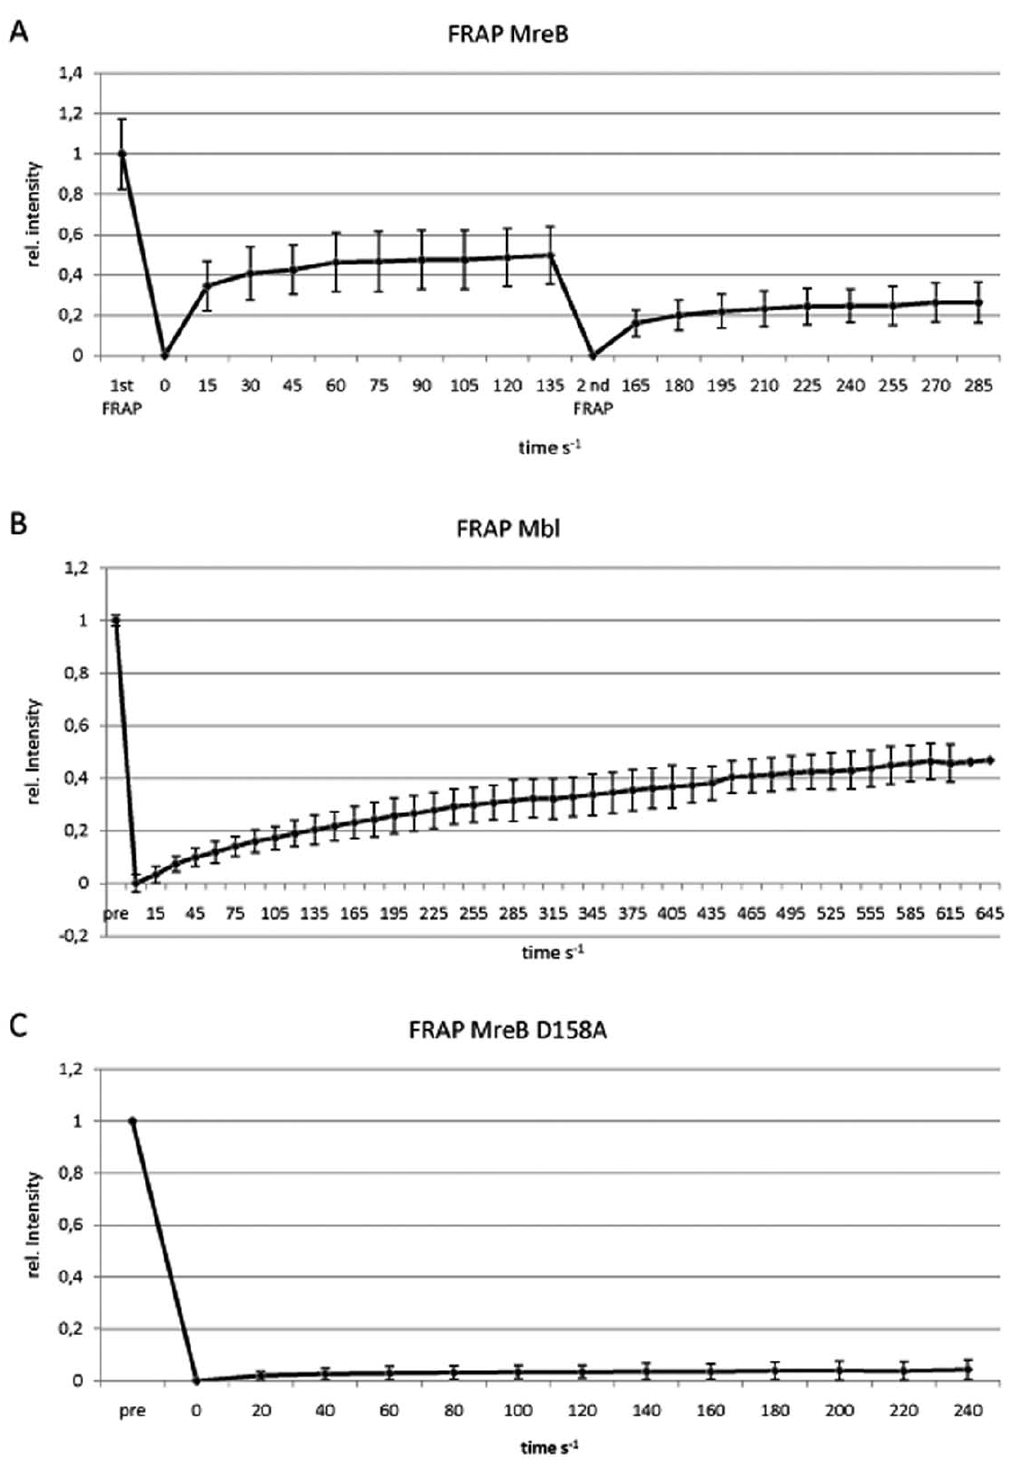
Figure 4. Quantification of FRAP analyses. X-axis show time in seconds, Y-axis relative fluorescence (1=100% of fluorescence before bleaching).